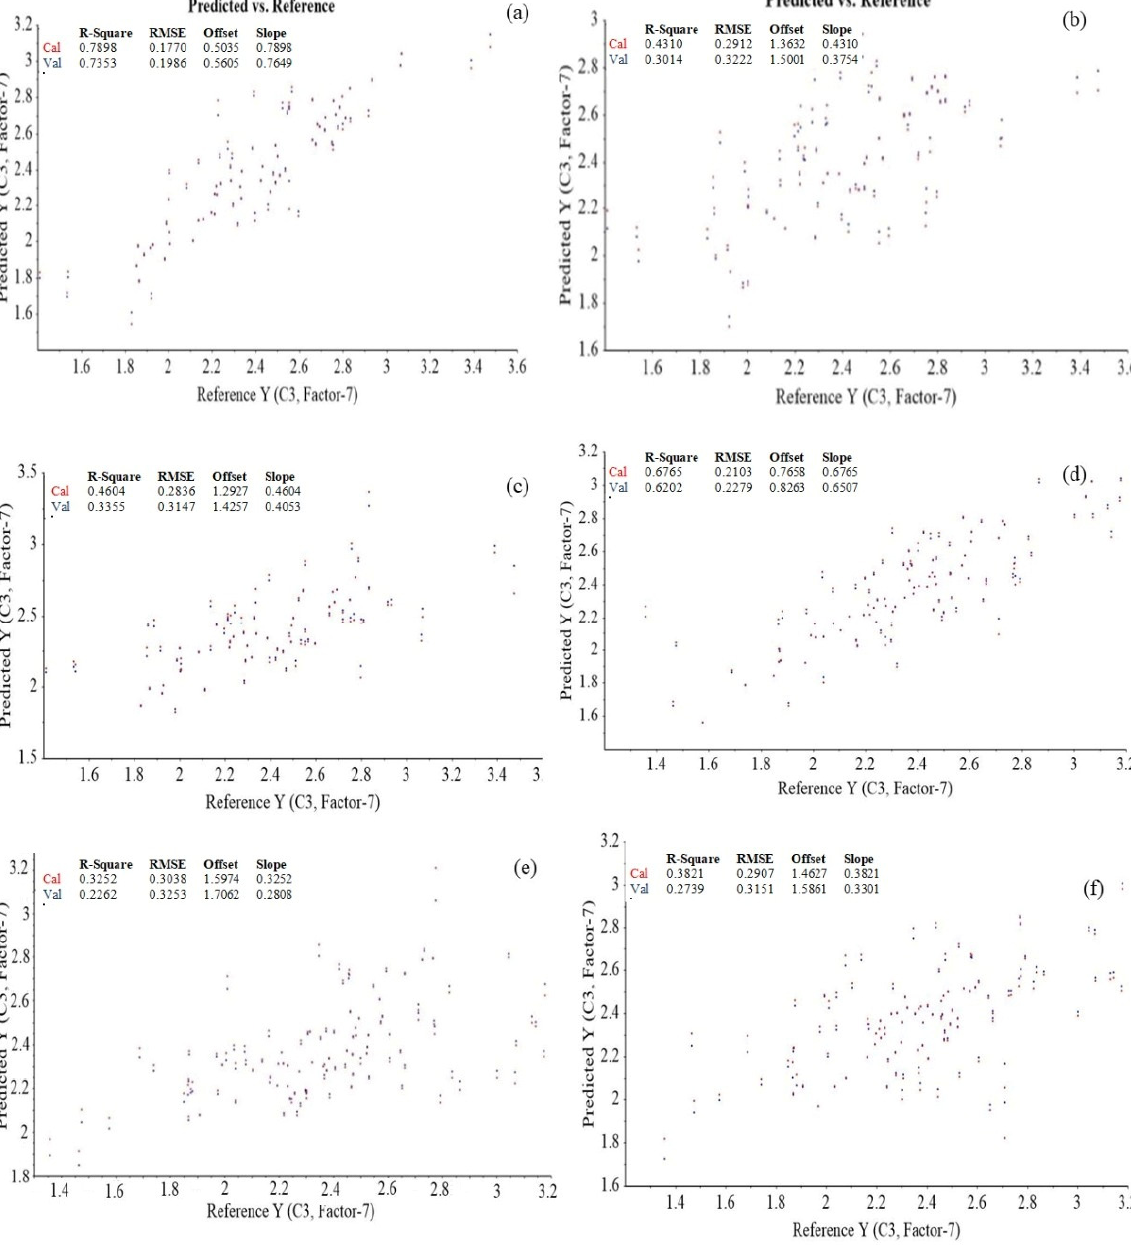
Figure 4. Partial least square model of β -glucan content in the wavelength ranges ( a ) 700–1300 nm, ( b ) 1300–1900 nm, and ( c ) 1900–2500 nm for hulled oats and ( d ) 700–1300 nm, ( e ) 1300–1900 nm, and ( f ) 1900–2500 nm for naked oats. Table 3. Statistical results of partial least square regression models developed to predict the β -glucan content of hulled and naked oat samples.